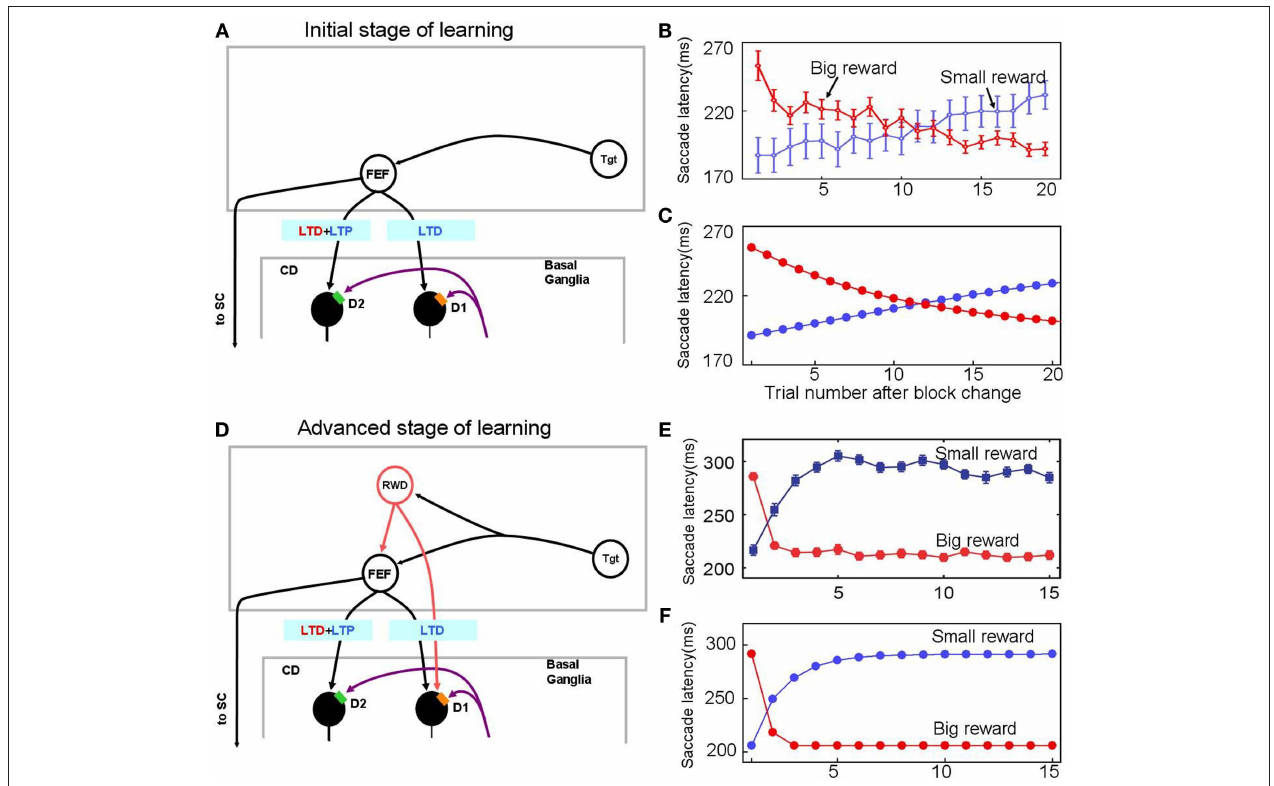
the big-to-small-reward transition [blue in (B,C) ] similarly by experimental observation (B) and computer simulation (C) . The saccade latency data in (B) is from monkeys C, D, and T. After sufficient experience of the 1DR task (D–F) , the saccade latency changes quickly as shown in experiments (e) and computer simulation (F) . This is mainly due to the additional excitatory input from the reward-category neurons. Note, however, that the decrease in saccade latency in the small-to-big-reward transition [red in (e,F) ] is quicker than the increase in saccade latency in the big-to-small-reward transition [blue in (e,F) ]. This asymmetry is due to the asymmetric learning algorithm operated by two parallel circuits in the basal ganglia illustrated in Figure 2. Figure (e) from Matsumoto and Hikosaka